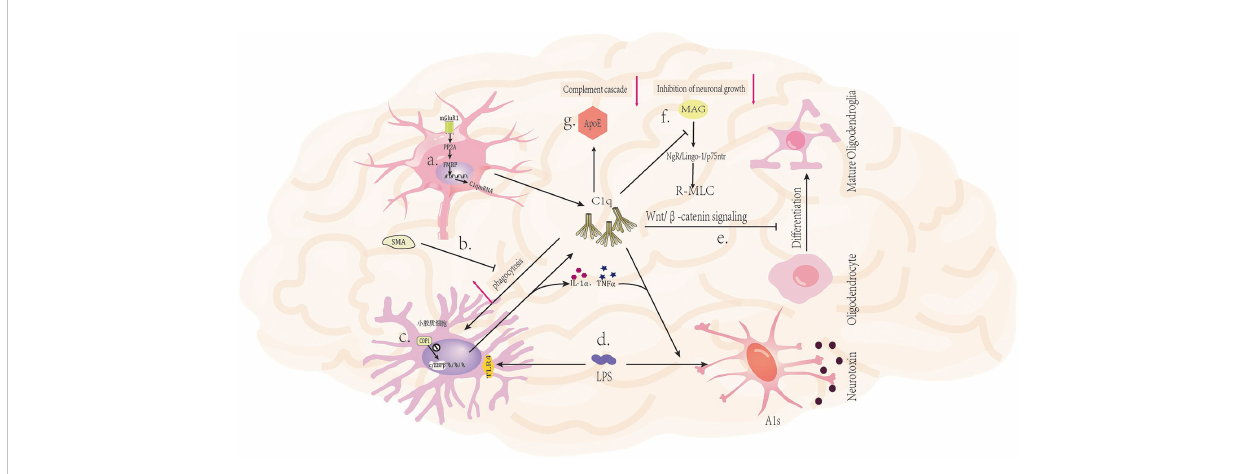
FIGURE 2 Mechanism of C1q in nervous system diseases. (A) Activation of glutamatergic neuronal mGluR1 receptors leads to increased expression of C1q mRNA (43). (B) The mGluR5 silent alteration modulator (SAM) inhibits C1q-mediated microglial phagocytosis (44). (C) The ubiquitin ligase COP1 regulates the transcription process of microglial in fl ammatory genes by controlling CCAAT/enhancer binding protein b (c/EBP b ) (45). (D) LPS (lipopolysaccharide) can bind to TLR4 receptors on microglia, triggering the secretion of C1q, Il-1 a , and TNF a by microglia, and inducing A1 in astrocytes (46). (E) C1q prevents the differentiation of oligodendrocyte progenitor cells (OPCs) into mature oligodendrocytes by inhibiting the Wnt/ b - catenin signaling pathway (47). (F) C1q interacts with MAG to reduce MAG inhibitory effect on neuronal signals, thereby promoting axonal growth (48). (G) The binding of ApoE to C1q inhibits the initiation of the classical complement cascade reaction